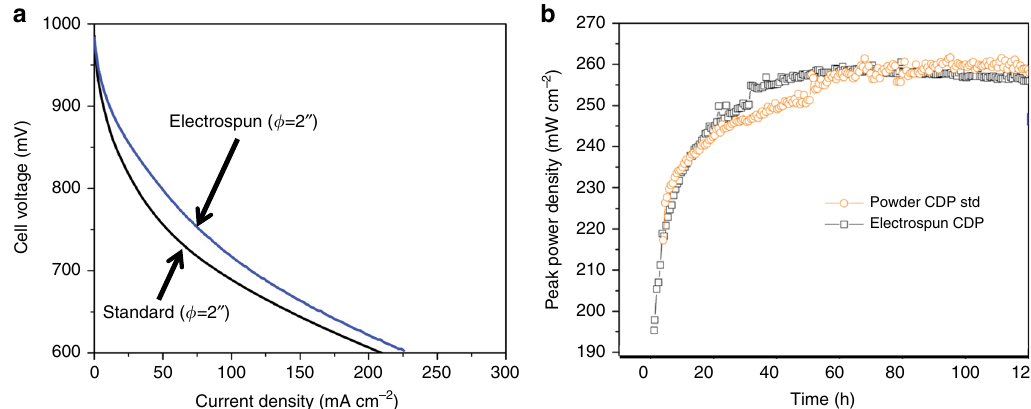
Fig. 8 Electrochemical performance of the nanoparticle-decorated sample. The sample material is caesium dihydrogen phosphate (CDP)- polyvinylpyrrolidone (PVP)-polyaniline (PANI) composite, used in a 2 ” diameter ( ∅ ) fuel cell. a The cell voltage at different current densities. The blue line represents the electrospun sample with the nanoparticle-decorated nano fi bres. The black line shows SAFCell Inc. ’ s standard (std) electrode. The electrospun sample has improved cell voltage at every current density. b The peak power density of the electrospun CDP sample with PVP-PANI is comparable with the standard powder SAFCell Inc. fuel cell electrode. The electrospun fuel cell power does not decrease in the fi rst 60 hours